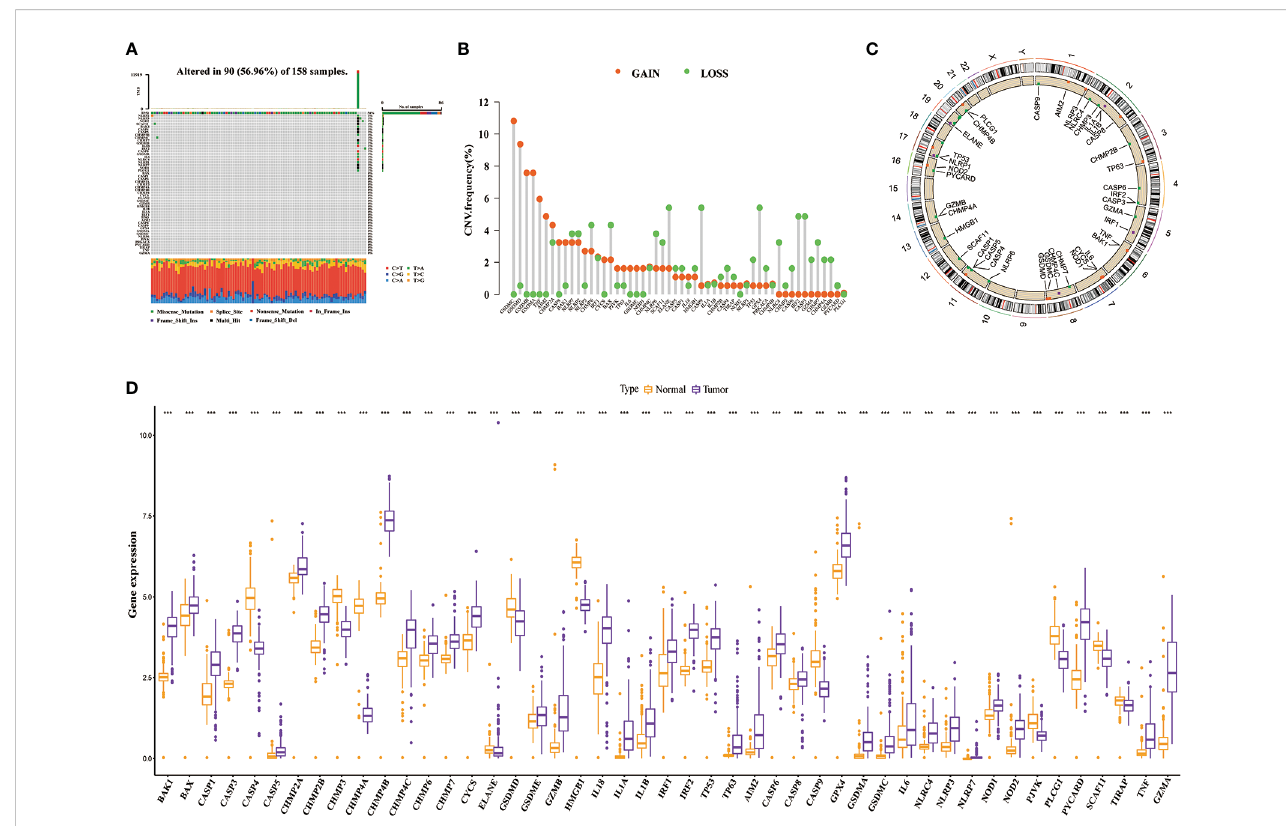
FIGURE 2 The genetic variation landscape of 52 pyroptosis-related genes (PRGs). (A) Somatic mutation frequency and type of PRGs. (B) Copy number variation frequency map of PRGs. (C) Copy number circle plot. (D) Differential expression of PRGs in the tumor and normal samples(Combined TCGA and GTEx databases). *** P <